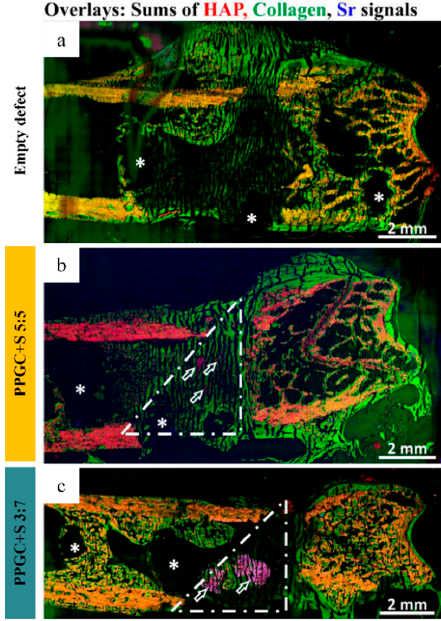
Figure 6. ToF-SIMS of Technovit-embedded sections of explanted femora. Stage scans of the bone cross-sections without a material ( a , empty defect), after implantation of PPGC + S 5:5 ( b ) and PPGC + S 3:7 ( c ). The RBG overlay mass images show for each sample an overlay of mineralized bone in form of hydroxyapatite (HAP) signals in red, non-mineralized bone areas in form of collagen signals in green, and strontium signals in blue (all signals are listed in Table S1). Thirty kiloelectron volt (keV) Bi 3+ primary ions were used for ToF-SIMS imaging in positive ion mode. The white lines mark the defect area and the white asterisks show former places of screws. White hollow arrows indicate the remaining material.